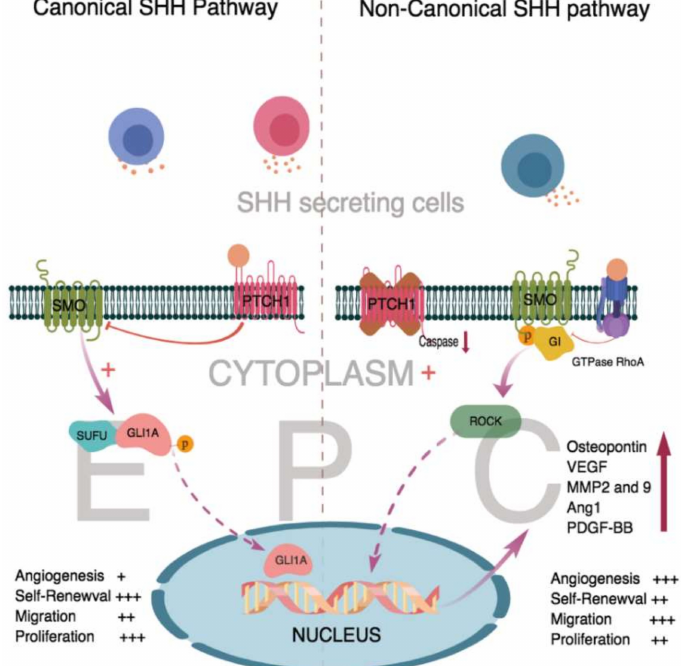
Figure 1. Canonical and Non-Canonical Sonic hedgehog (SHH) signaling pathway in endothelial progenitor cells (EPCs) and endothelial cells (ECs). SHH molecule binds and activate the 12-pass transmembrane cell surface receptor Patched 1 (PTCH 1) that inhibits the smoothened (SMO) receptor to activate the binding of suppressor of fused (SUFU) and glioma-associated oncogene homolog1-A (GlLI 1A) to form a complex by autophosphorylation. EPCs are mostly activated by the non-canonical SHH signaling pathway in